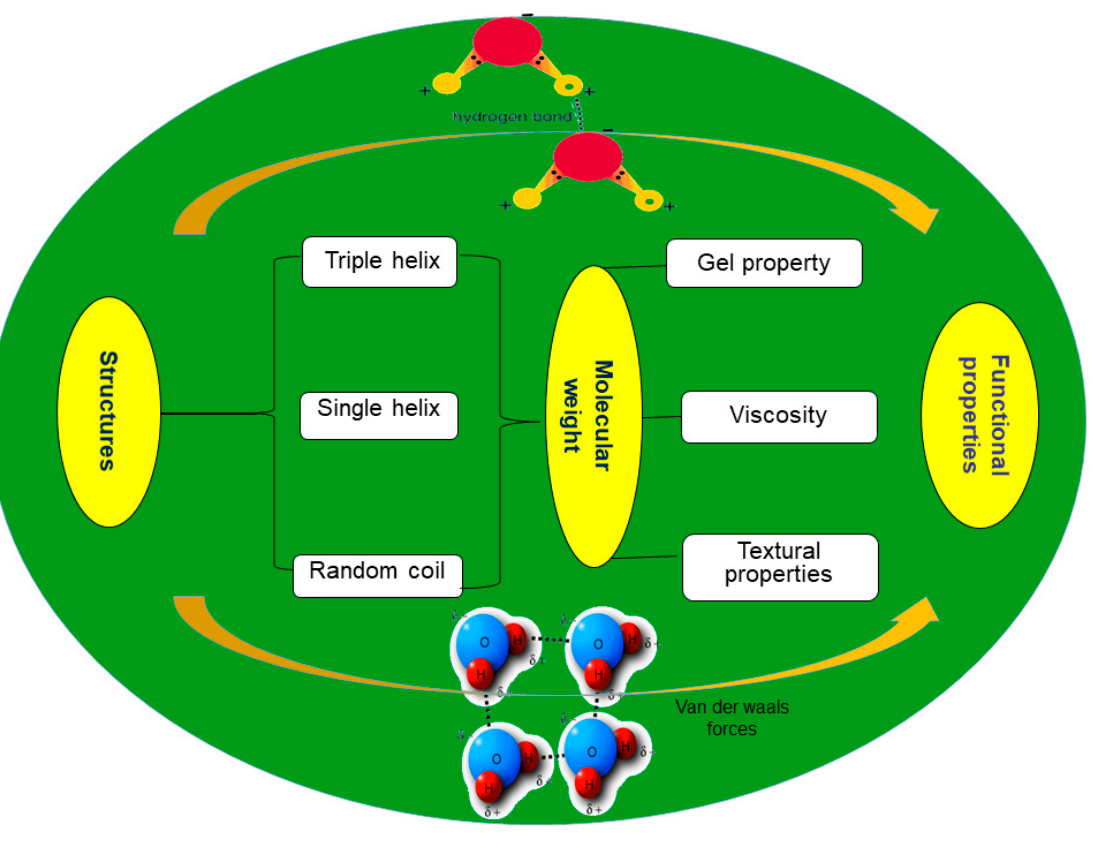
Figure 2. The relationship between structure and function of β -glucan.